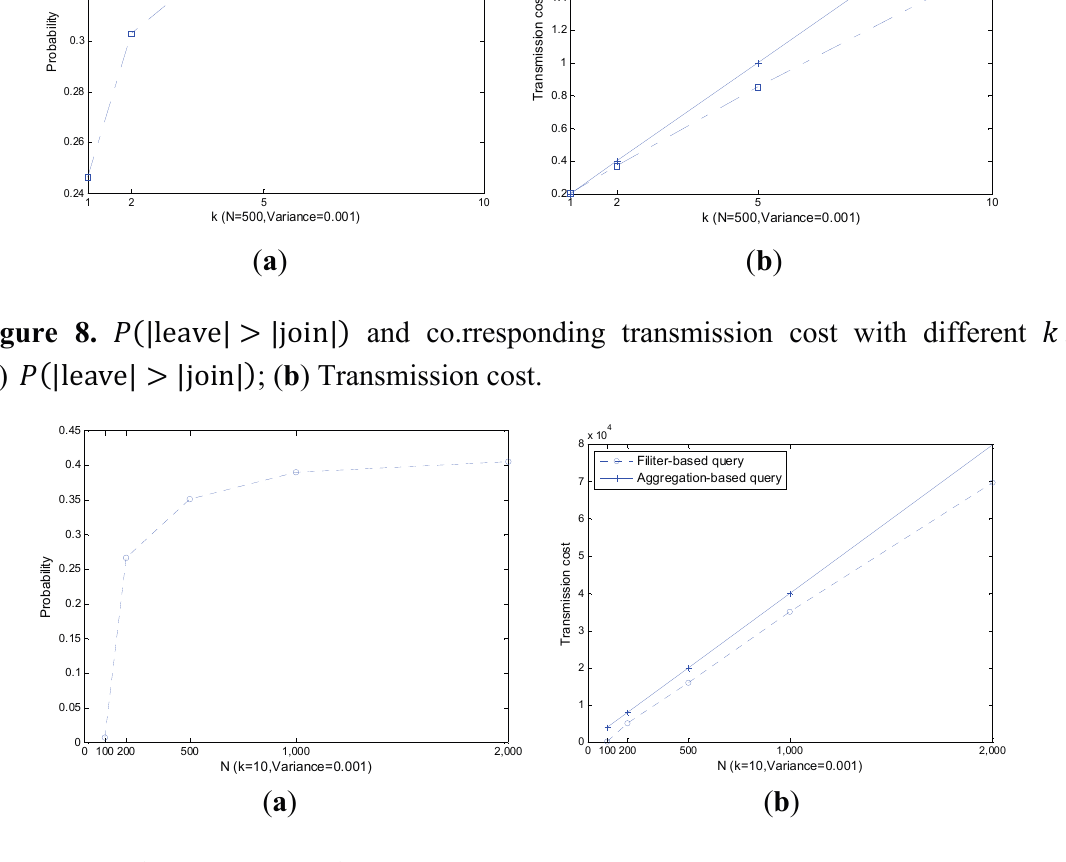
Figure 9. (cid:1842)(|leave| > |join|) and corresponding transmission cost with different (cid:1840) . ( a ) (cid:1842)(|leave| > |join|) ; ( b ) Transmission cost.